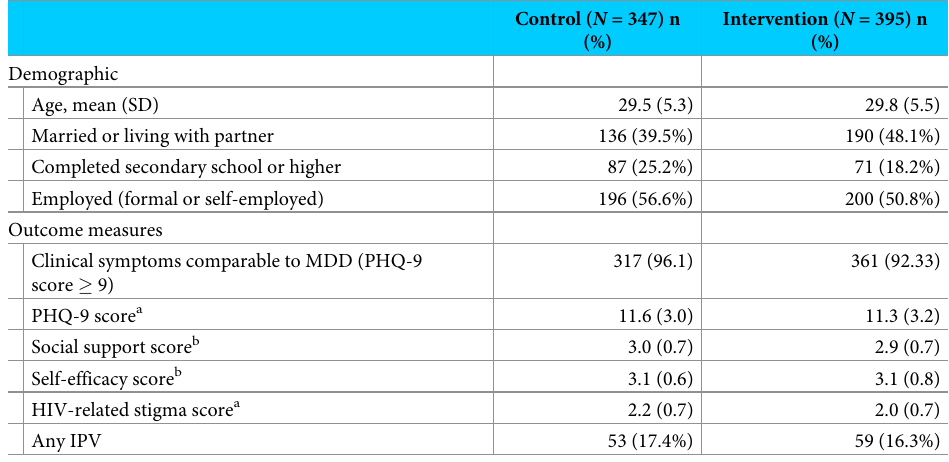
Table 1. Baseline AU : AbbreviationlistshavebeencompiledforthoseusedinTables 1 (cid:0) 4 : Pleaseverifythatallentriesarecorrect : sociodemographic and outcome measures for study population.